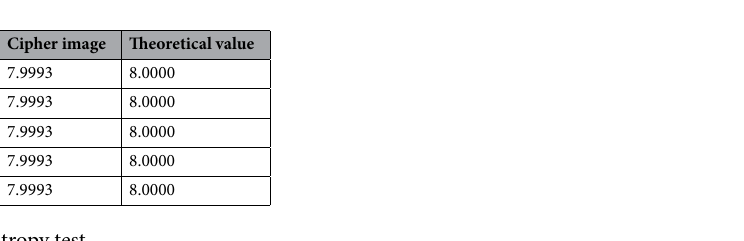
Table 7. Information entropy